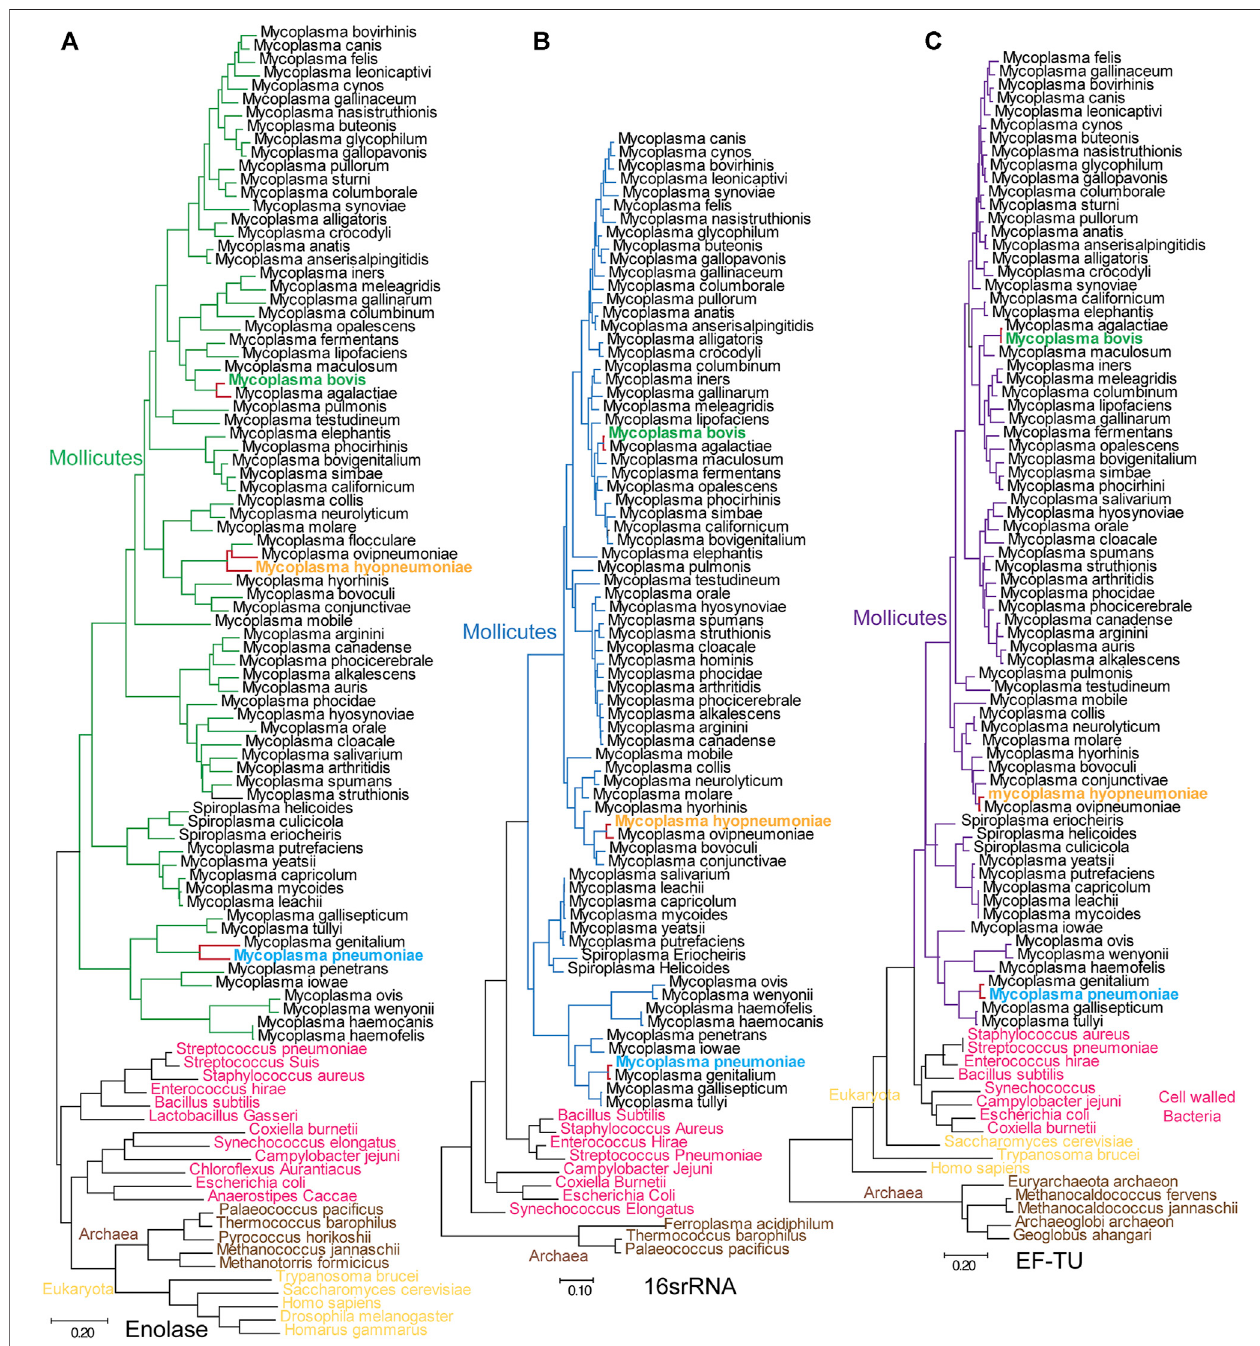
FIGURE 7 | Mycoplasmataceae evolutionary trees generated from enolase, EF-TU and 16S rRNA sequences. (A – C) Evolutionary trees generated with enolase, 16S rRNA and EF-TU sequences. Bars indicate distances under the corresponding tree. Mycoplasma bovis , M. pneumoniae and M. hyopneumoniae are shown in green, blue and orange, respectively. The branches for M. pneumoniae , M. genitalium , M. hyopneumoni ae and M. ovipneumoniae are red in all three trees to clarify the distance between neighboring species.